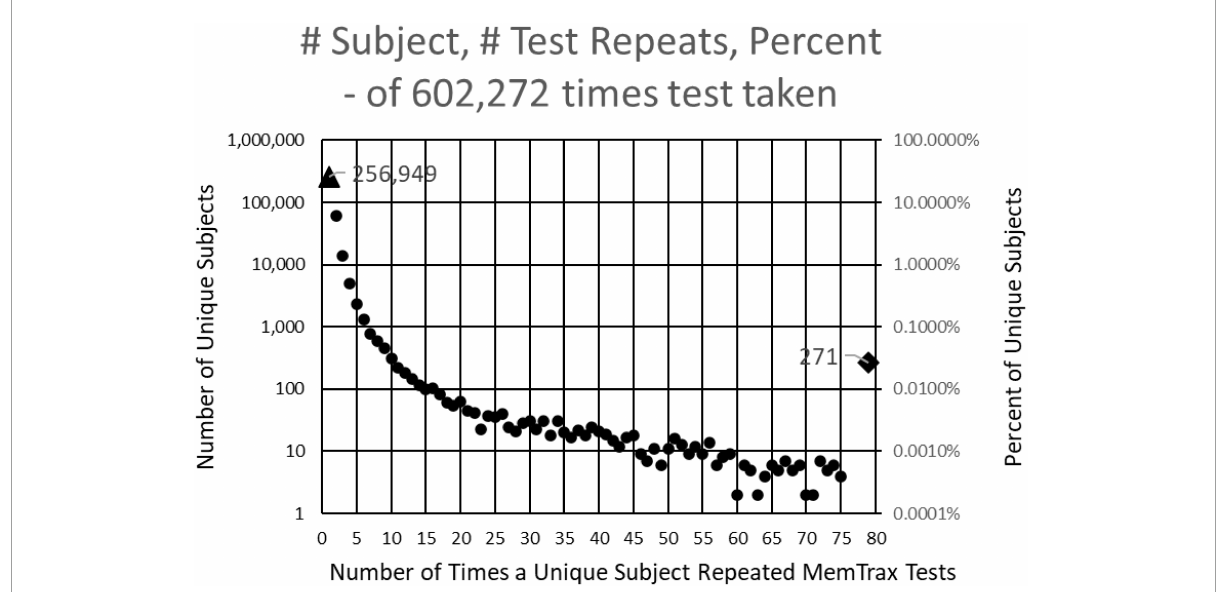
FIGURE1 Number of subjects (left log scale) and percentage (right log scale) taking each number of tests. 344,165 presumably unique individuals took the test. Of these, 256,949 took the test only one time, and 60,642 took the test only two times. Two hundred and seventy-one took the test more than 75 times and 18 took the test more than 1,000